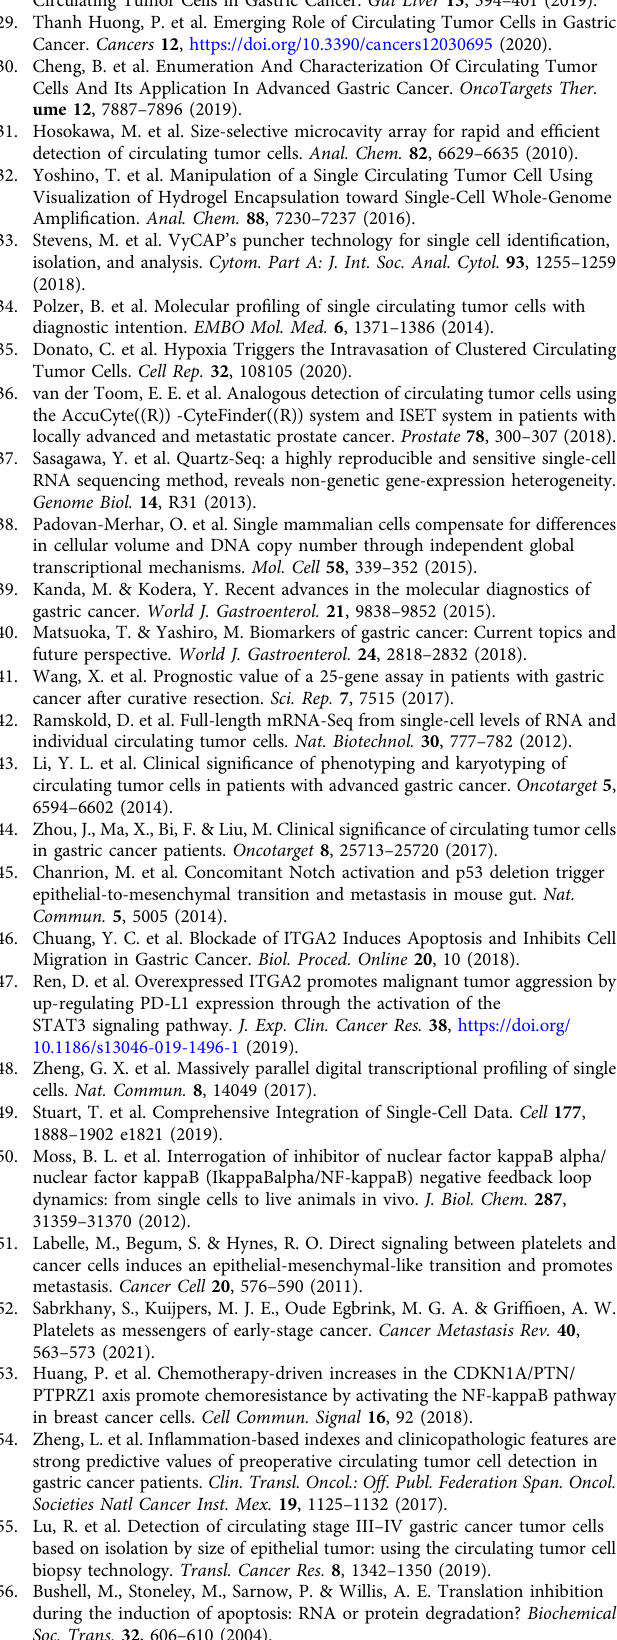
Supplementary Figs. 1 – 5 as Supplementary Data 10 – 14. Single-cell RNA-seq data were deposited at